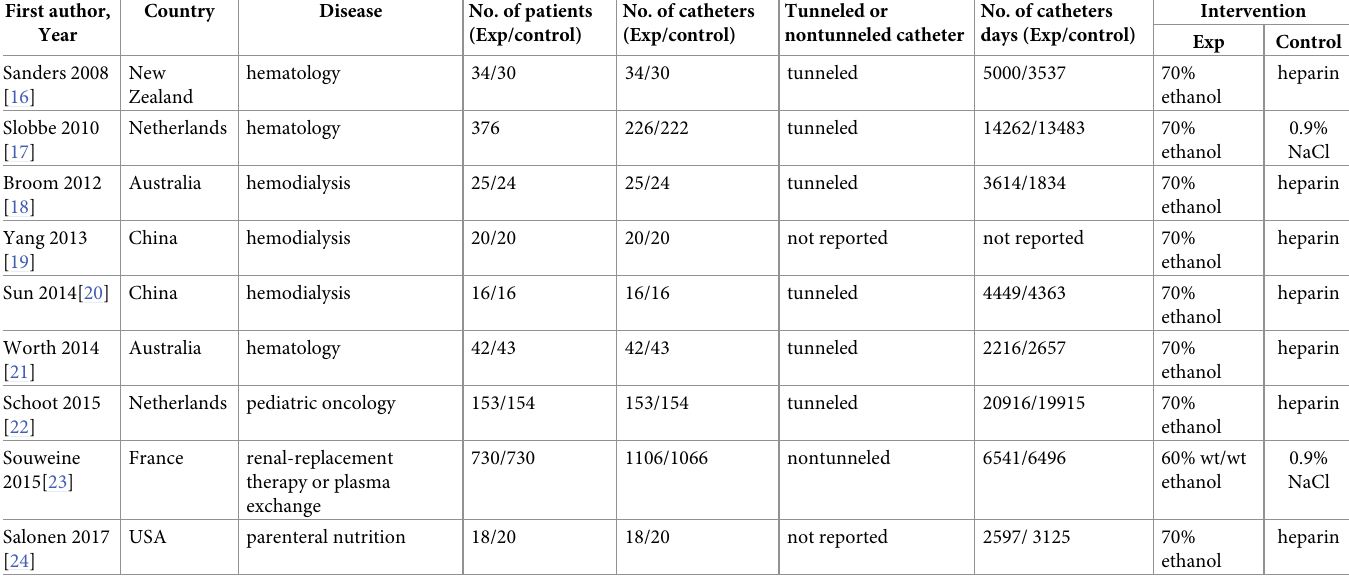
Table 1. Characteristic of the included